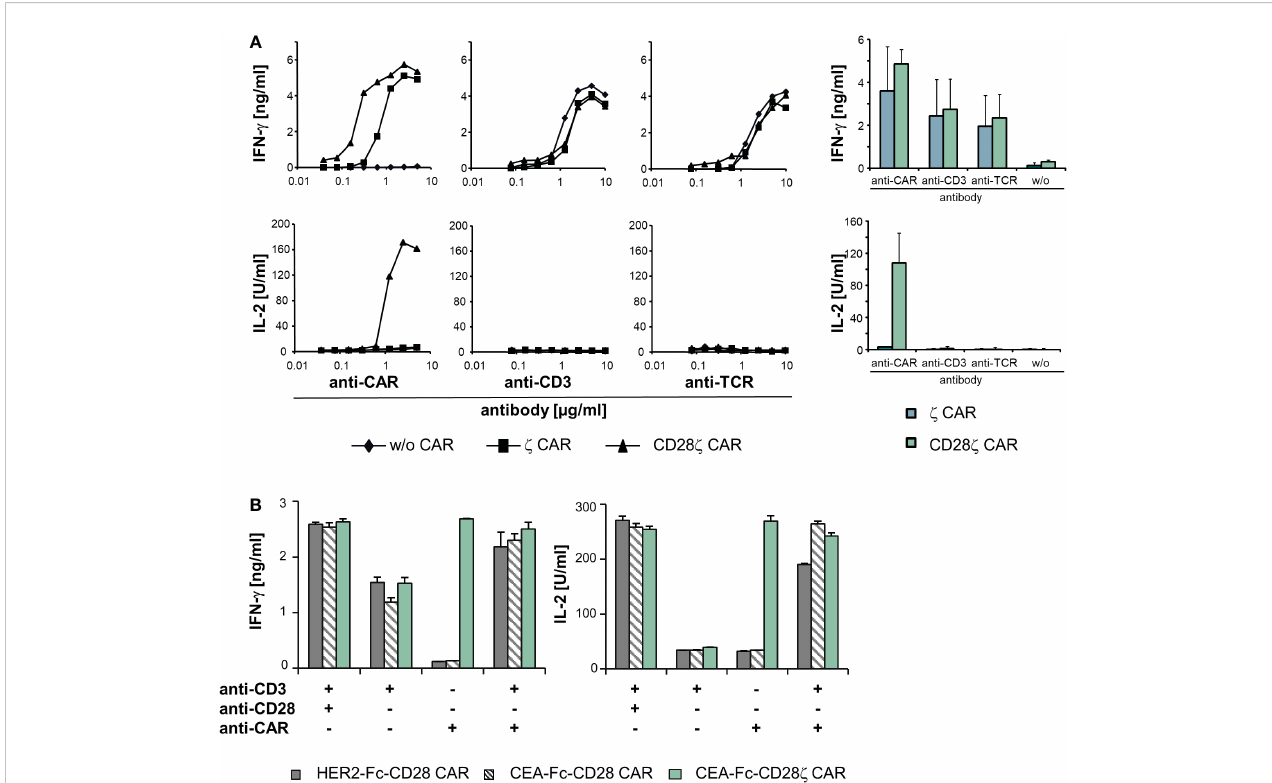
FIGURE 5 The TCR/CD3 complex and z − chain CARs can complement in signaling. (A) T cells of healthy donors (5 x 10 4 cells/well) were engineered with a z or CD28 z CAR, respectively, and cultivated for 48 h in micro-titer plates that were coated with serial dilutions (starting from 10 µg/ml) of an anti − IgG1 Fc antibody for CAR activation or an agonistic anti − CD3 and anti − TCR antibody, respectively. Data from a representative T cell donor are shown; data from four donors were accumulated in mean values ± SD. (B) T cells (5 x 10 4 cells/well) expressing an anti-HER2-Fc-CD28, anti-CEA-Fc-CD28 or anti-CEA-Fc-CD28 z CAR were cultivated for 48 h in micro-titer plates coated with an agonistic anti − CD3 (1 µg/ml) and anti − CD28 (5 µg/ml) antibody, respectively, or the anti − idiotypic antibody BW2064/36 (8 m g/ml), directed against the binding domain of the anti − CEA CAR, or recombinant HER2-Fc protein (8 m g/ml) recognized by the anti − HER2 CAR, respectively. Combinations of antibodies and/or antigen were used as indicated. Culture supernatants were analyzed for IFN − g or IL − 2 by ELISA as indicated. Numbers represent mean values of technical triplicates ± SD. A representative experiment out of at least three experiments is